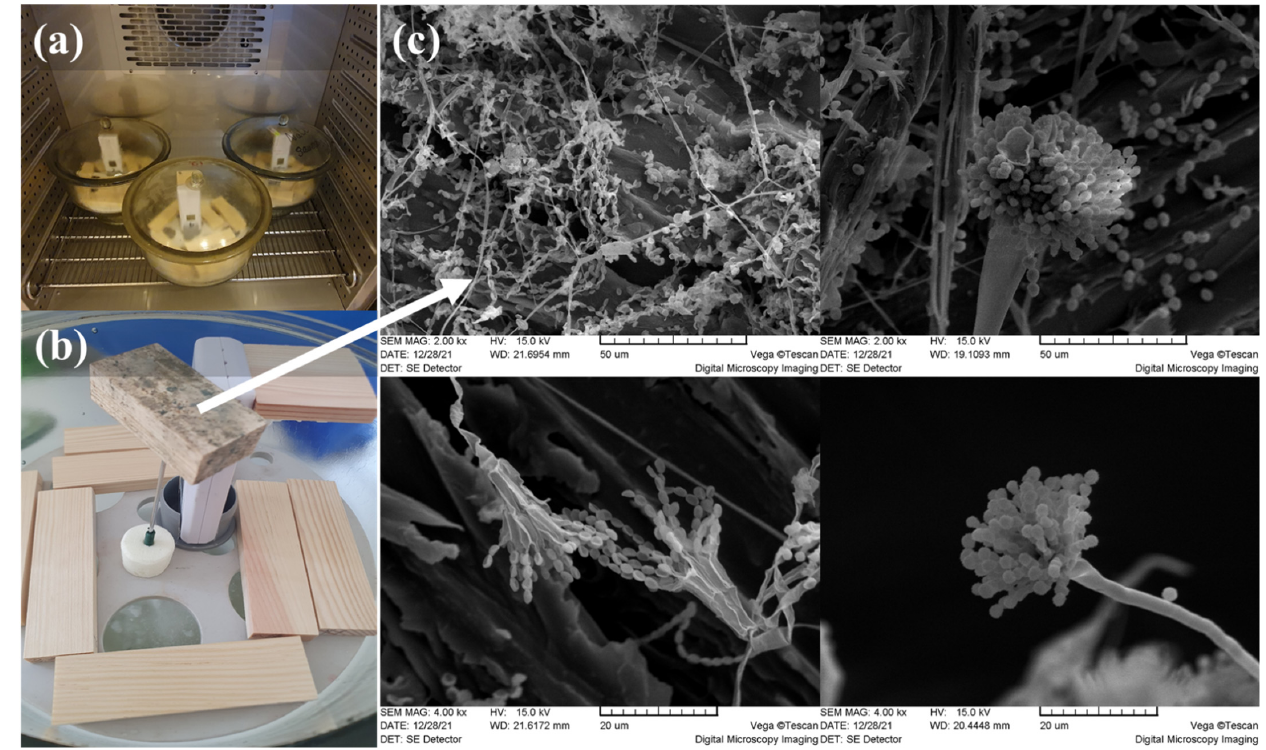
Figure 1. Illustration of the experiments: ( a ) test containers in a climate chamber; ( b ) setup of the test with mould-infected wood (experiments III and IV); ( c ) SEM images of the mould-infected wood specimen.